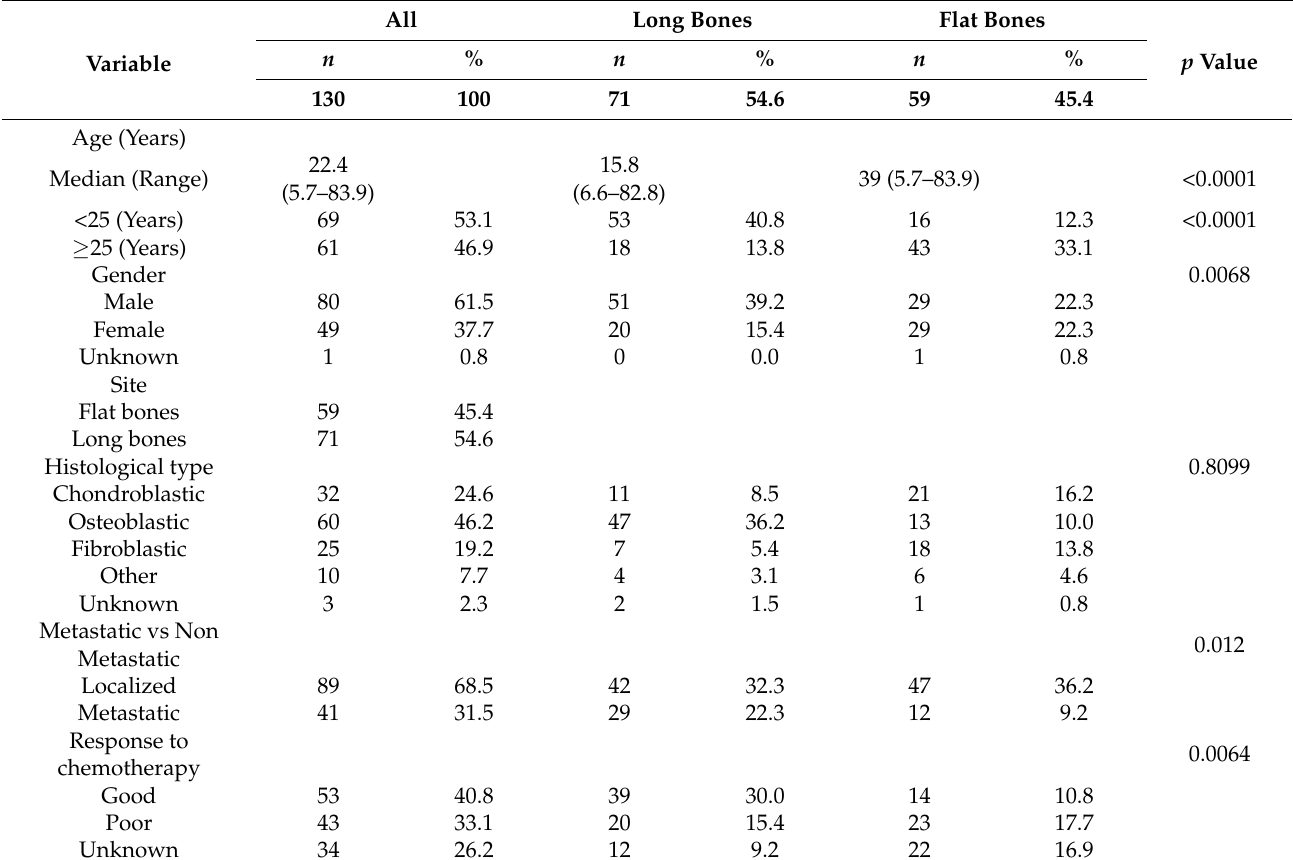
Table 1. Patient and tumor